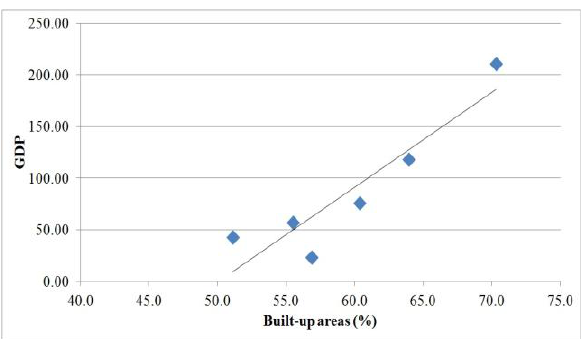
Figure 14. Relationship between the percentage of built-up areas and population for 2005 ( R 2 = 0.72)